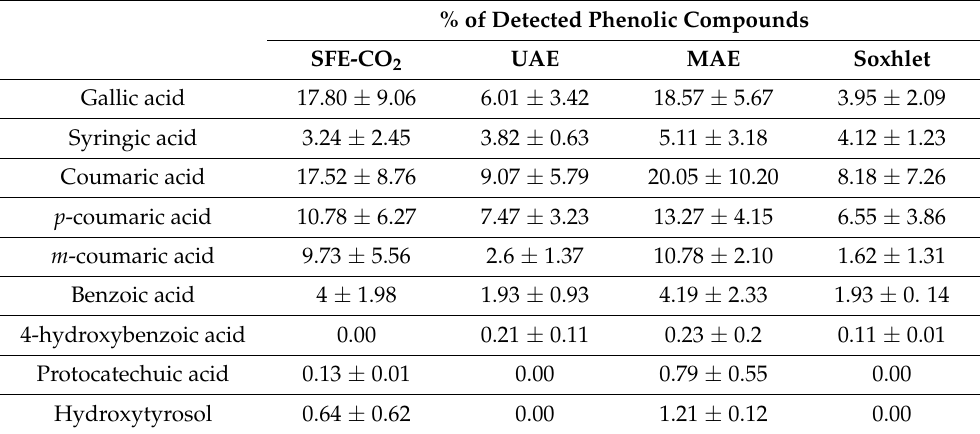
Figure 6. Chromatograms of detected phenolic compounds by the different extraction methods, ( A ) microwave-assisted extraction, ( B ) supercritical fluid extraction, ( C ) ultrasound-assisted extrac- tion, ( D ) Soxhlet extraction. Table 2. Comparison of phenolic compounds identified carob pods with different extraction